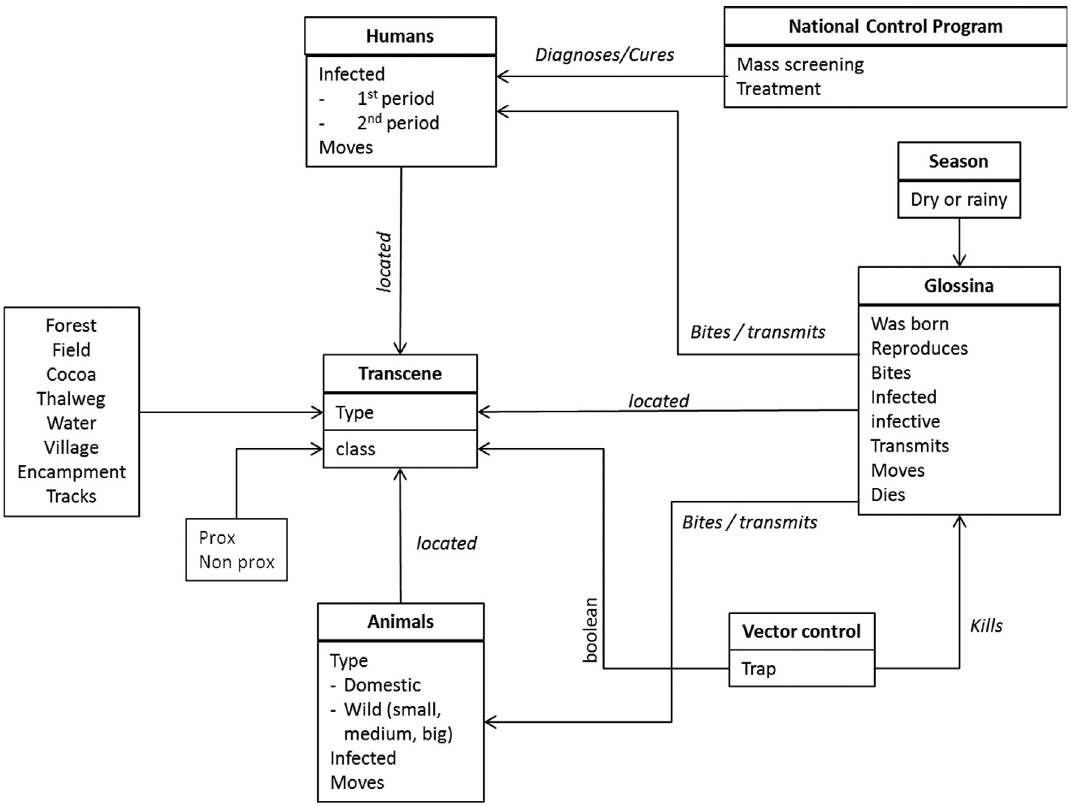
Figure 2. Organigram of interactions between agents in HATSim.